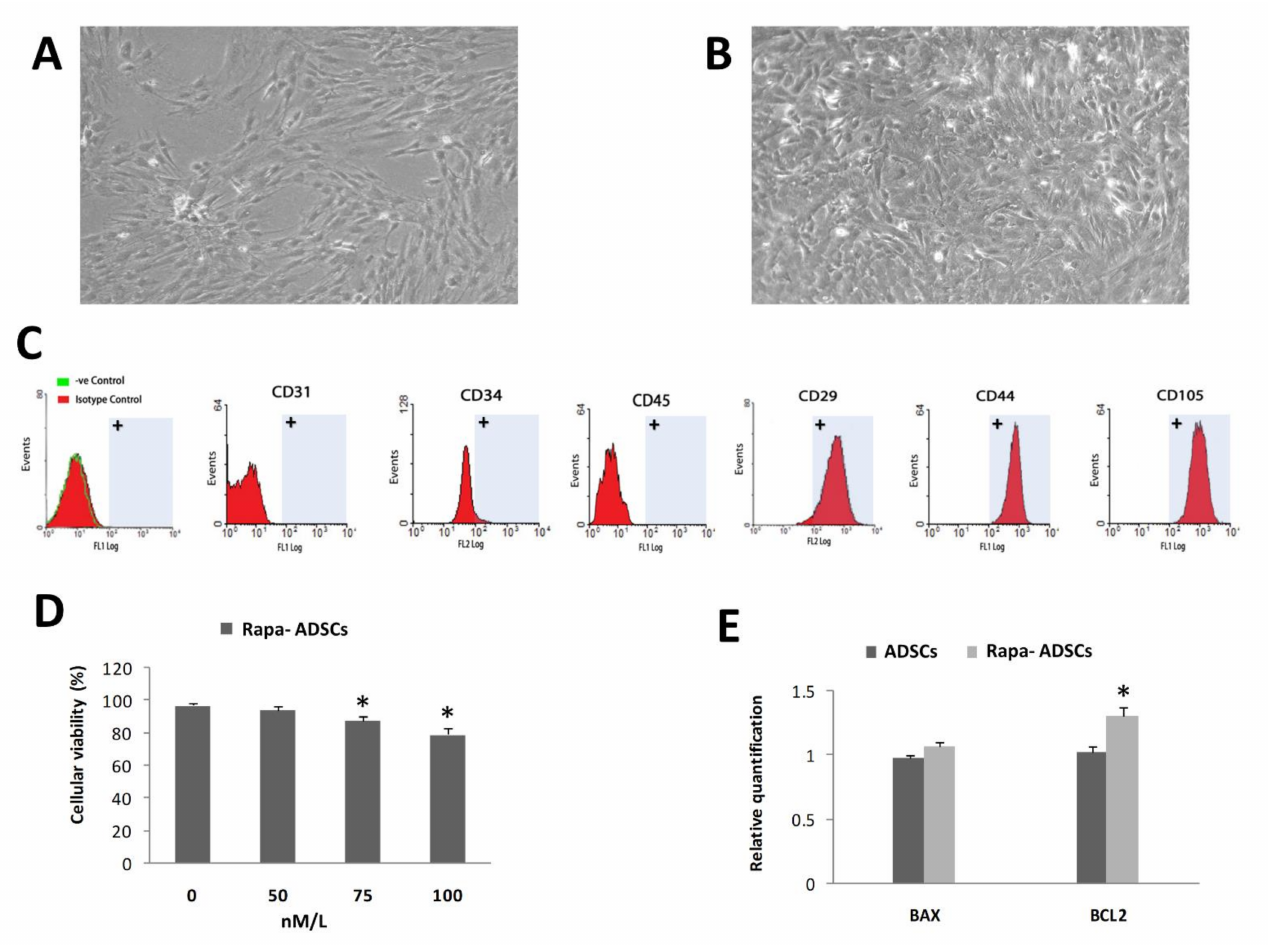
Figure 1. Effect of rapamycin preconditioning for 2 h on ADSCs. ( A ) Typical fibroblast-like morphology of cultured ADSCs. ( B ) Cultured ADSCs with 50 nM/L rapamycin. ( C ) Surface characterization of different stem cells markers on isolated ADSCs by flow cytometry. ( D ) Effects of different concentrations of rapamycin, 0, 50, 75 and 100 nM/L, on ADSCs viability. ( E ) Effect of 50 nM/L rapamycin on expression of BAX and BCL2 in non-preconditioned and preconditioned ADSCs. Statistical significance, * = p <